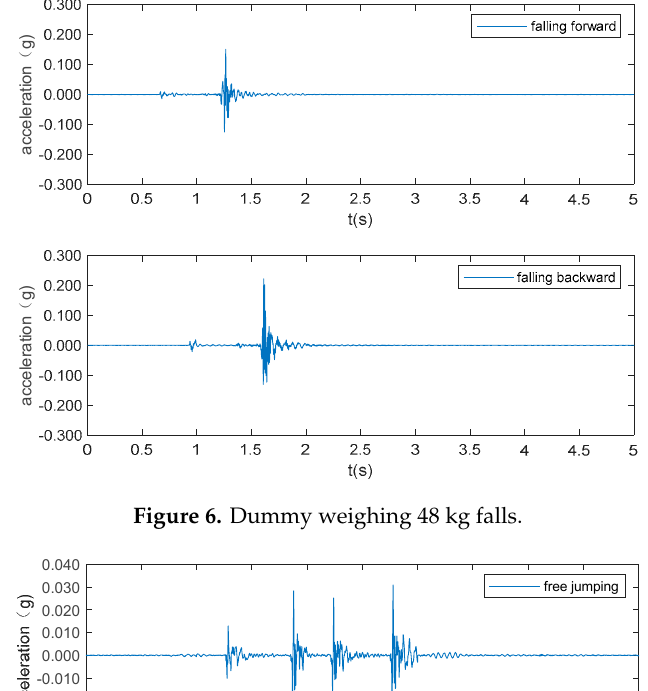
Figure 6. Dummy weighing 48 kg falls.